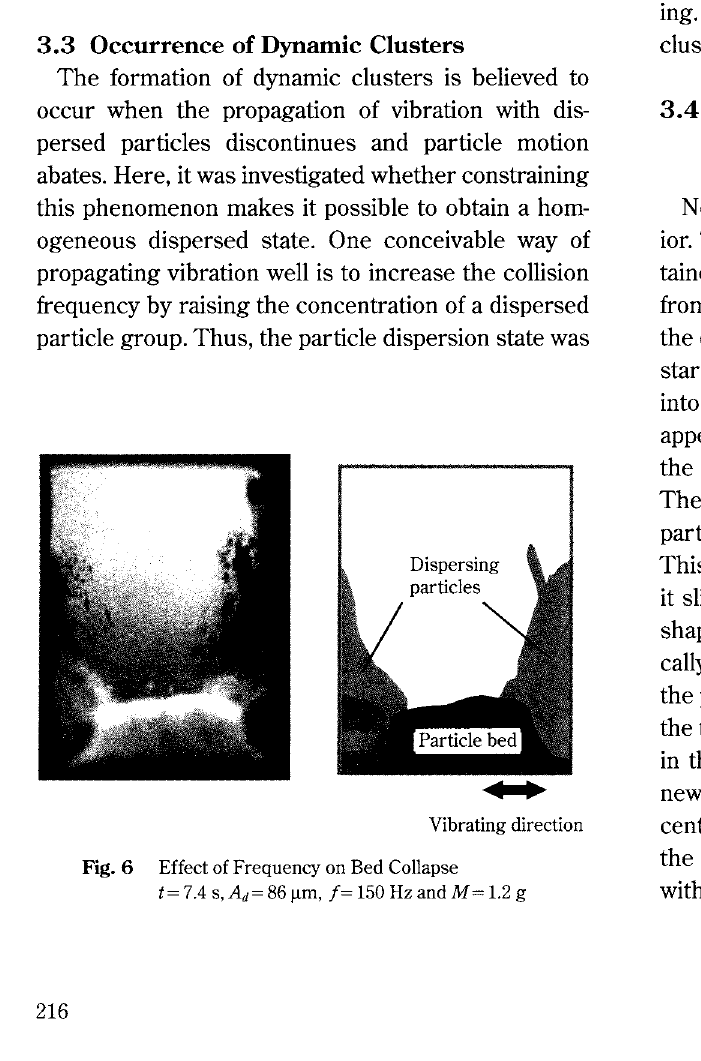
Fig. 6 Effect of Frequency on Bed Collapse t= 7.4 s. Ad= 86 Jlm. f= 150Hz and M= 1.2